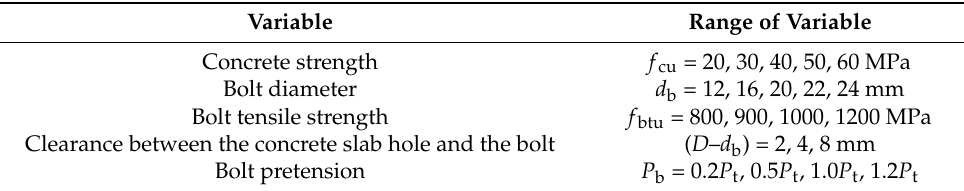
Table 3. Variables selected for parametric studies.